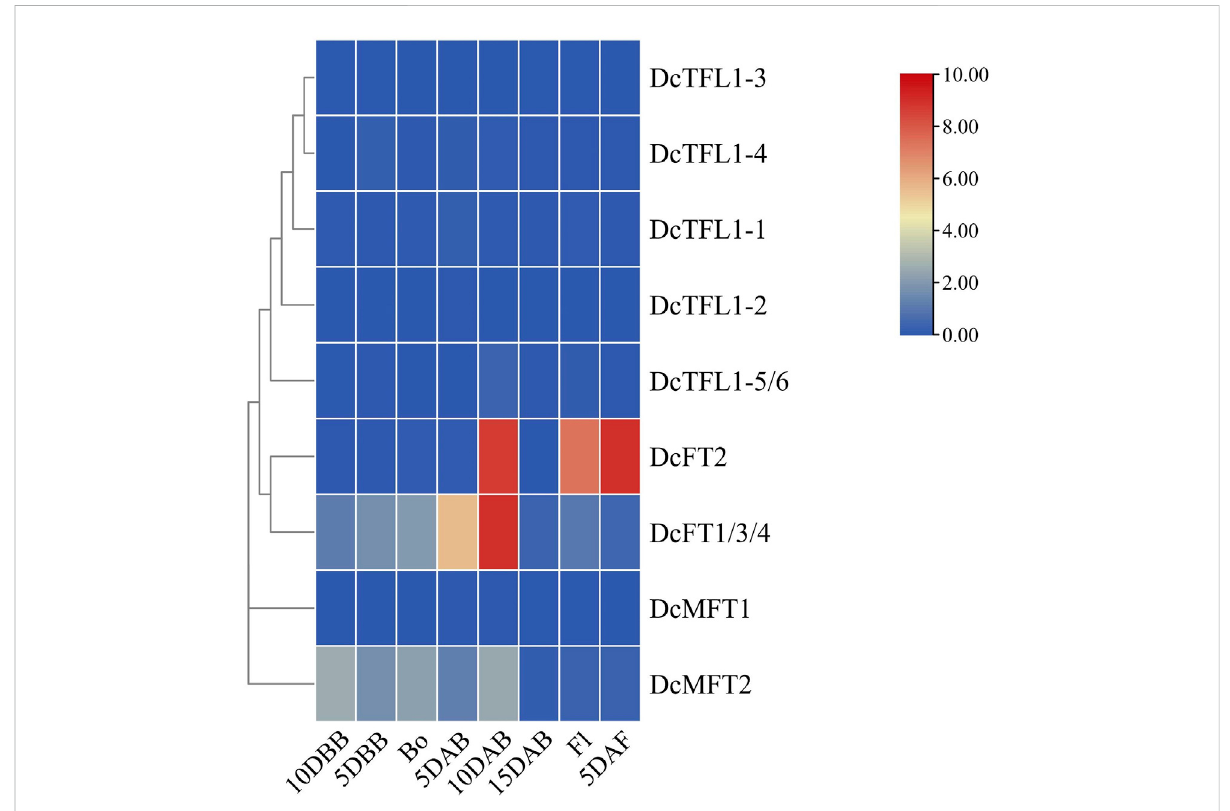
FIGURE 6 Relative expression of carrot PEBP genes from bolting to fl owing. DBB: days before bolting, Bo: bolting, DAB: days after bolting, Fl: fl owering, DAF: days after fl owering. The color scale with red and blue represent high and low values, respectively; color scale from 0 to